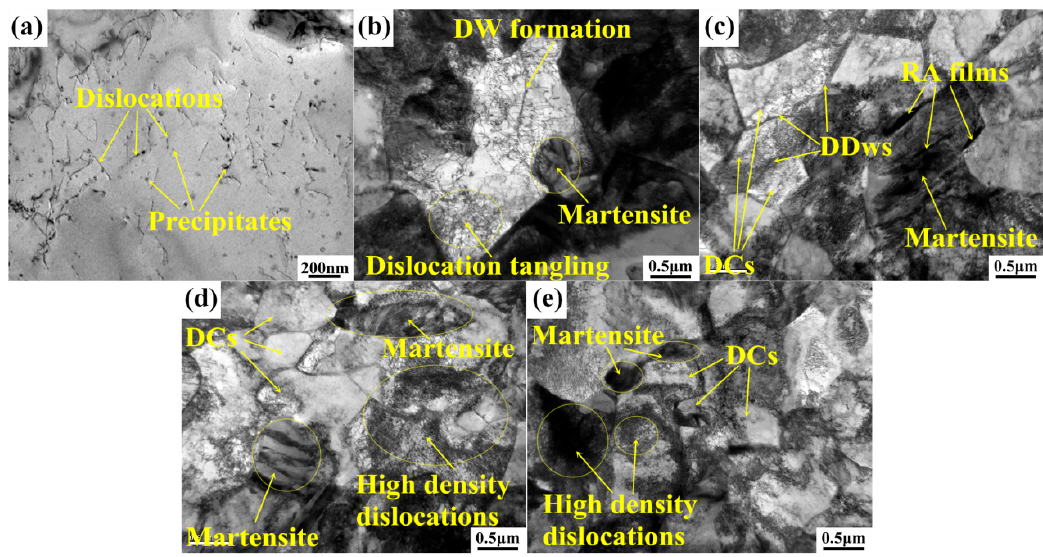
Figure 8. TEM micrographs of dislocations and precipitates in ferrite before deformation: ( a ) precipitates and dislocations in ferrite. Substructures formation procedure accompanied with growing dislocation density in ferrite at incremental strain levels: ( b ) 5%, ( c ) 10%, ( d ) 15%, and ( e ) 20%.